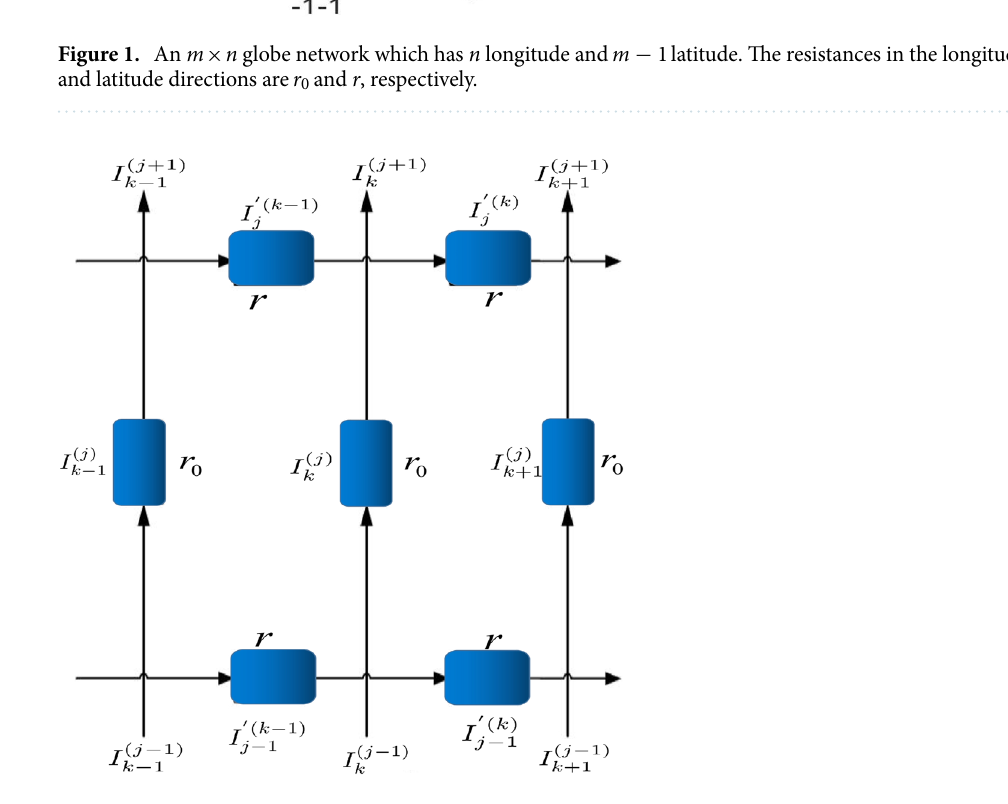
Figure 2. Segment of the globe network with current directions and